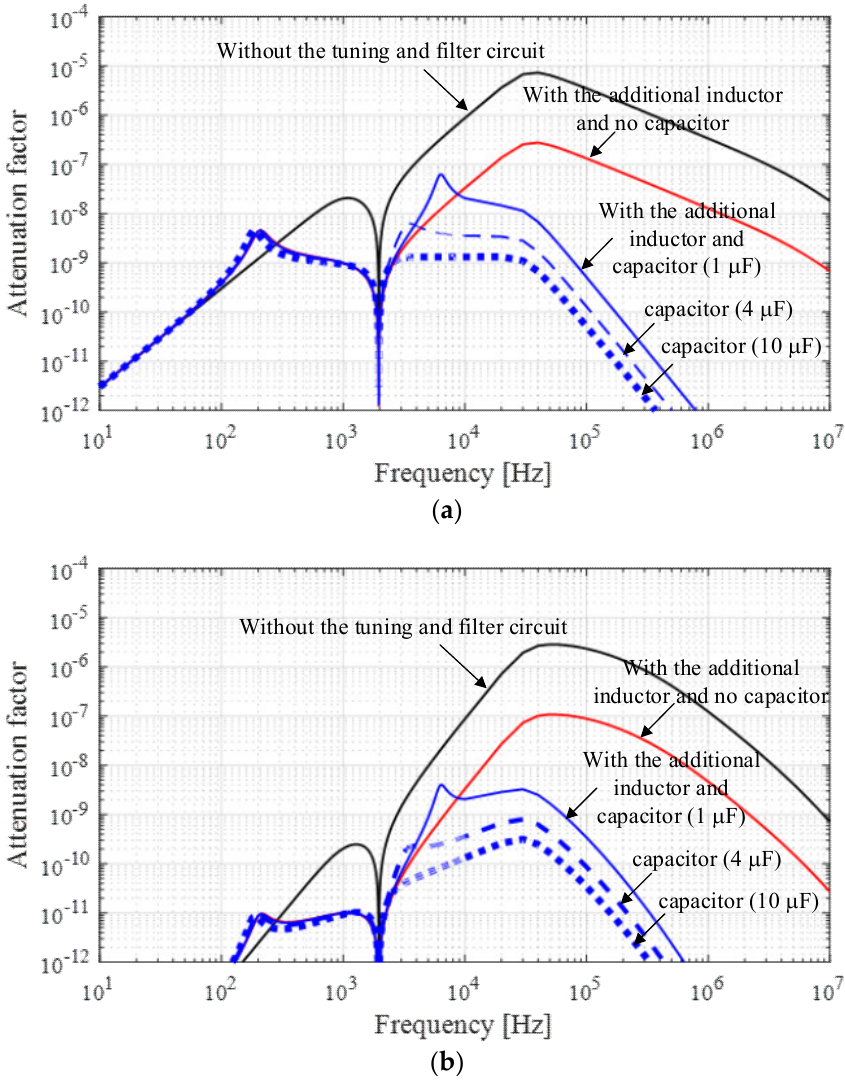
Figure 15. Attenuation factor at the PD port of the testing system: ( a ) without the band-pass filter; ( b ) with the band-pass filter recommended by the standard.